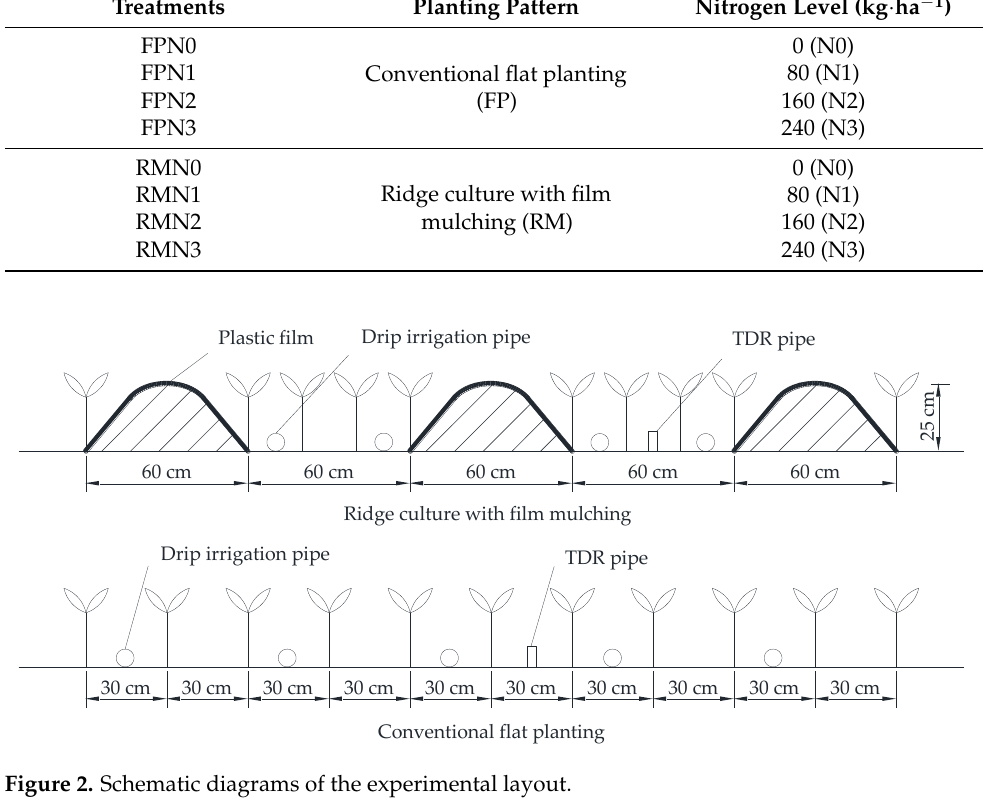
Figure 2. Schematic diagrams of the experimental layout.